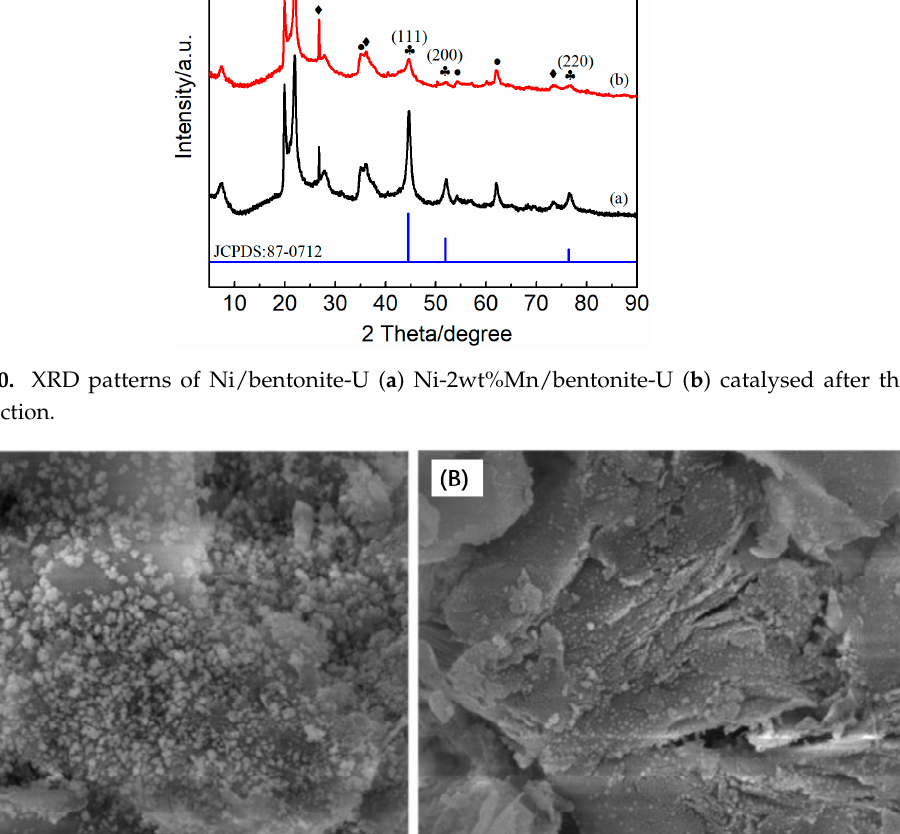
Figure 11. SEM images of Ni/bentonite-U ( A ), Ni-2wt%Mn/bentonite-U ( B ) catalysed after 150 h stability tests.